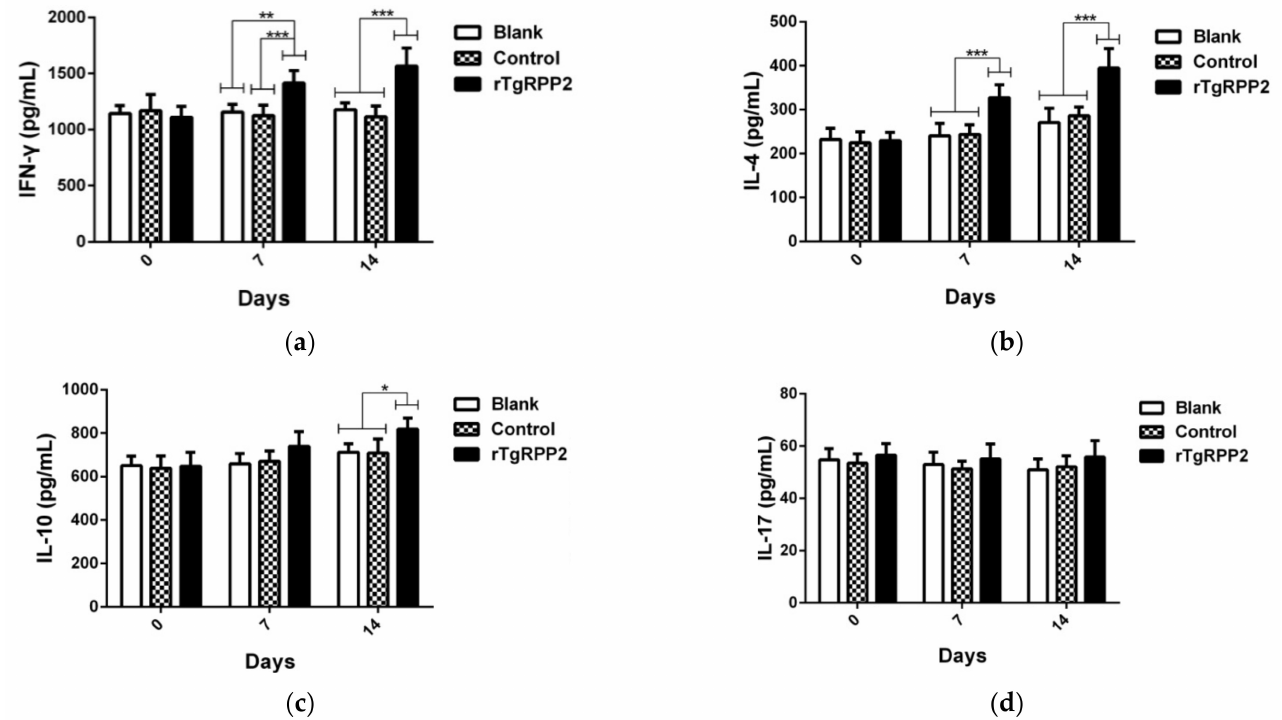
Figure 9. Cytokine production. Double antibody sandwich ELISA kits were used to determine the level of IFN- γ ( a ), IL-4 ( b ), IL-10 ( c ), and IL-17 ( d ) in sera from animals. Results were evaluated using one-way ANOVA analysis, followed by Dunnett’s test, and values are shown as the mean ± standard deviation ( n = 5). * p < 0.05, ** p < 0.01, and *** p < 0.001 compared with the blank group or the control